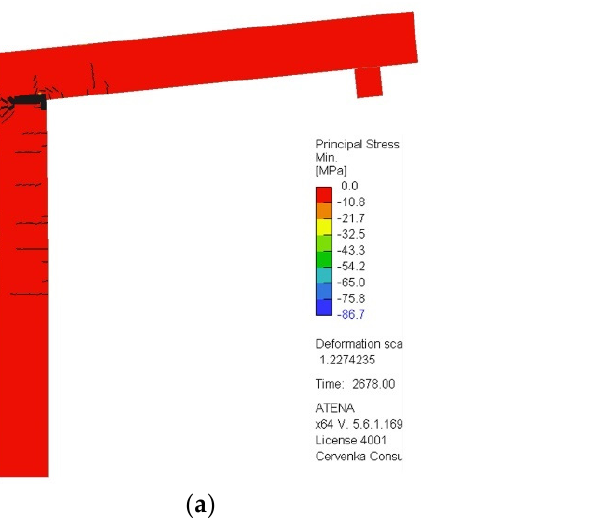
Figure 8. Mode of failure as predicted by the numerical analysis. Principal stress of the concrete matrix ( a ) and equivalent principal strain of carbon composite reinforcement ( b ) at the time of the failure.